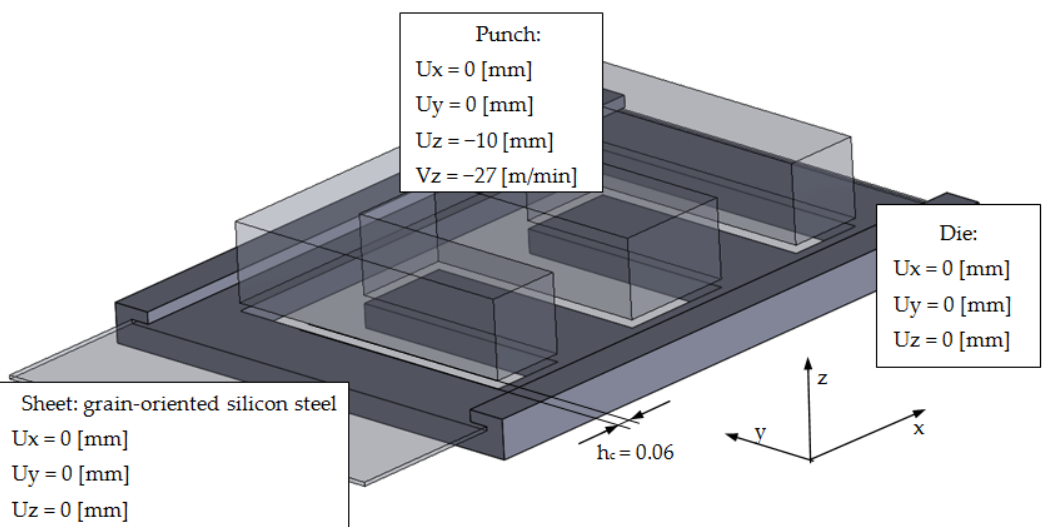
Figure 18. Geometrical model of blanking process with optimal technological parameters.